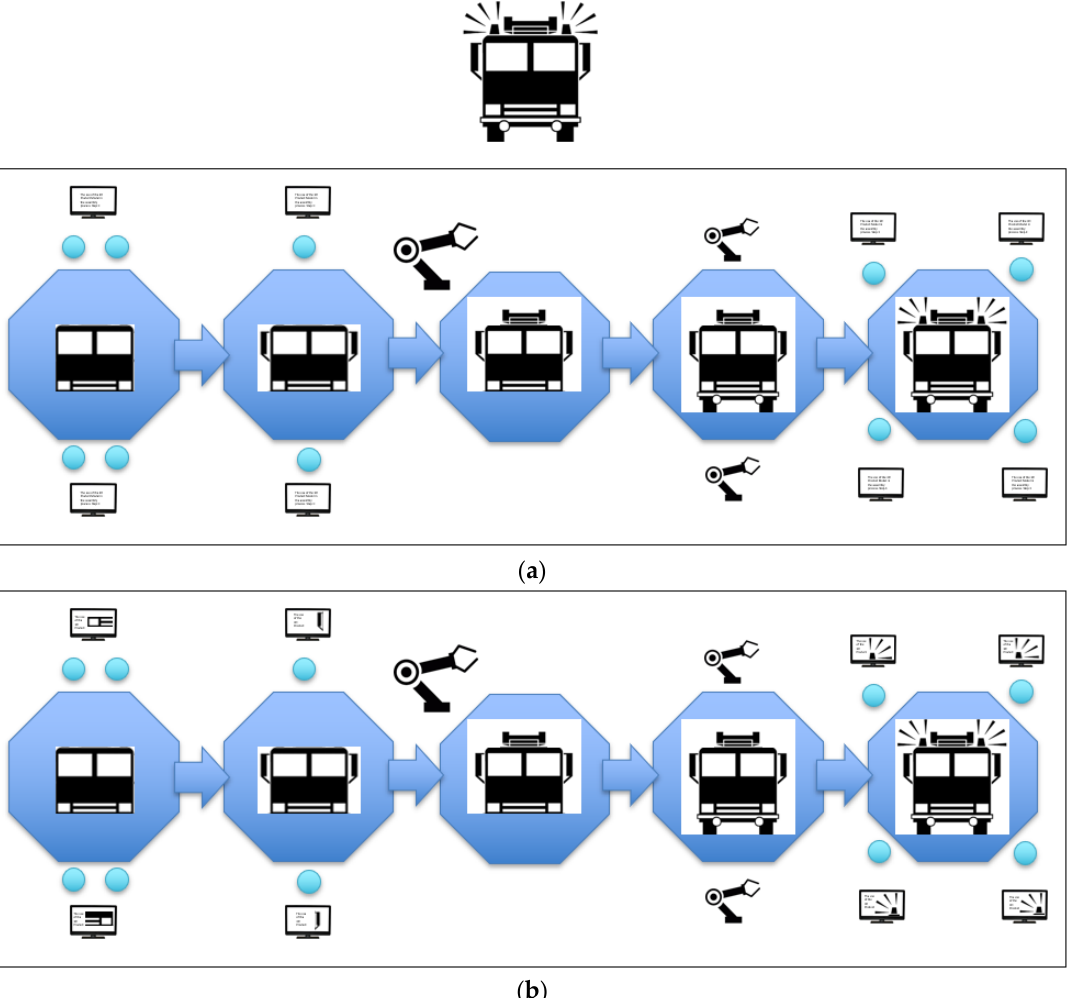
Figure 1. Assembly process: ( a ) using written work instructions; ( b ) deploying the 3D product model to the shop floor. Reprinted with permission from [1]. Copyright 2021 MDPI.